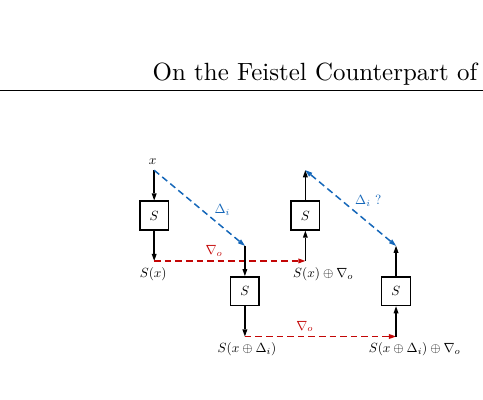
Figure 4: The value of BCT (∆ i , ∇ o ) corresponds to the number of Sbox inputs x that make the boomerang over 1 round come back.